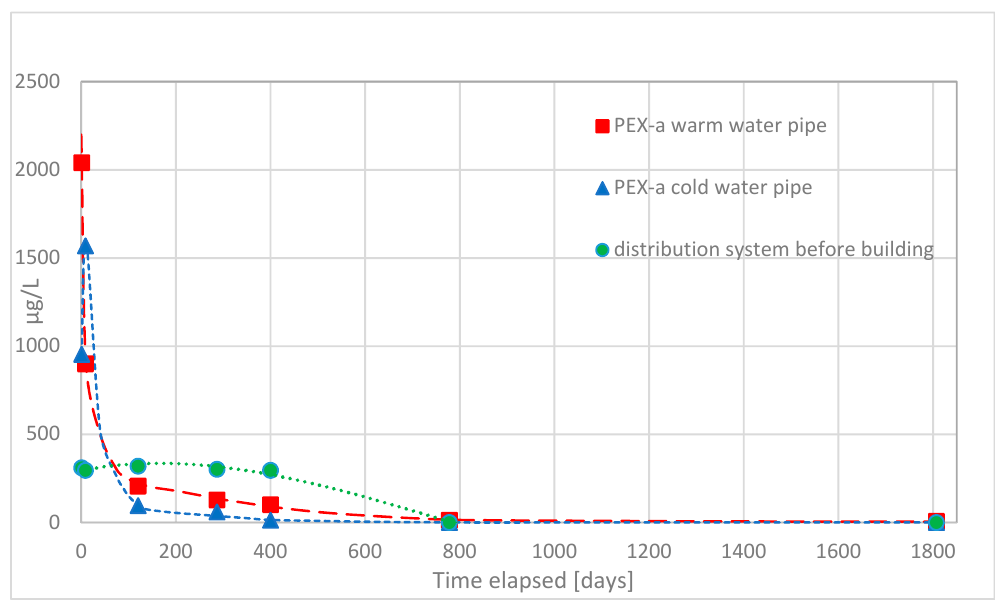
Figure 2. The observed concentrations of migrated tert-butyl alcohol (TBA), during the first five years of use of the office building, from the PEX-a water pipes into the drinking water and their corresponding concentration in the water entering the building from the waterworks distribution system.